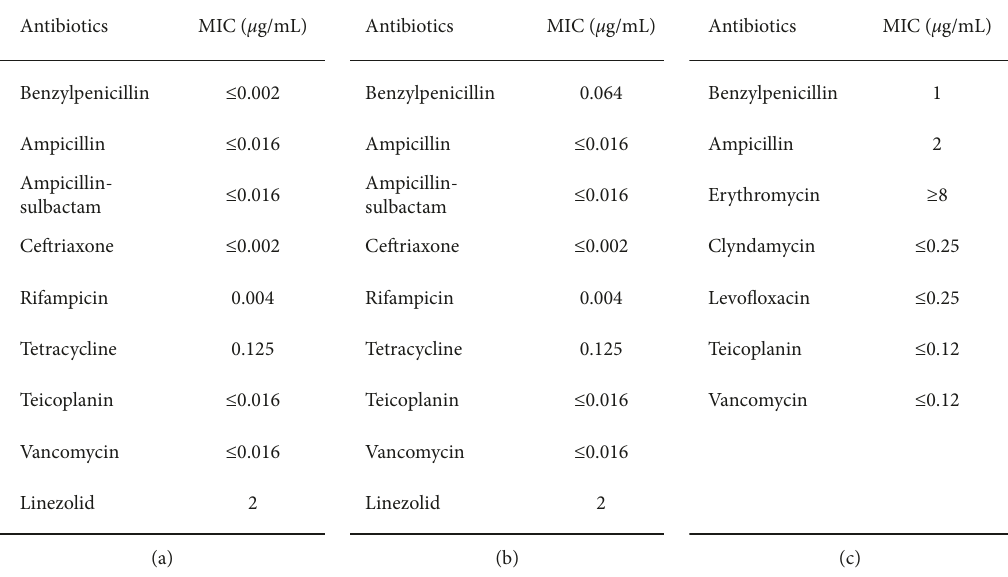
Figure 1: Antibiograms and MICs of Granulicatella adiacens and Abiotrophia defectiva strains isolated from the clinical cases. (a) Case 1 G.